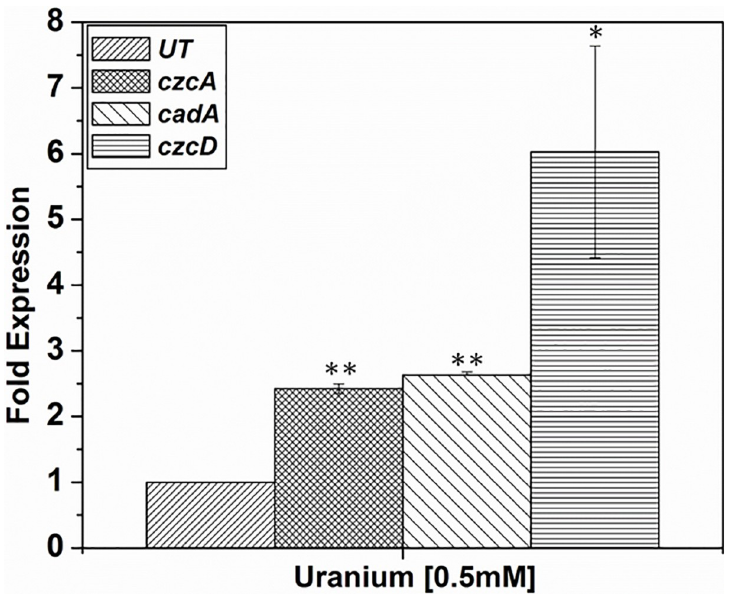
Fig 4. Expression of metal transporter genes in the presence of uranium. Expression of czcA , czcD and cadA genes in response to treatment with 0.5mM U. Expression of these genes was normalized to the expression of the 16SrRNA gene. Statistical significance was performed using Student’s test (p � 0.05 � ; p � 0.01 � 0.001 �� ; p � 0.001 ���